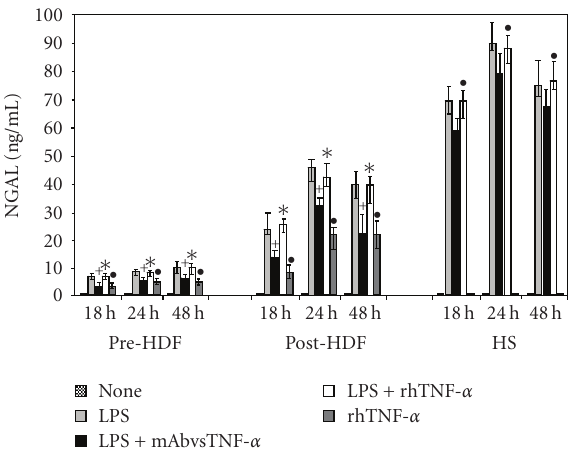
Figure 2: Role of TNF- α on the kinetics of NGAL production by PMG from preHDF and postHDF patients and HS. + Significantly di ff erent ( P < . 05) from that of LPS-stimulated PMG. ∗ Significantly di ff erent ( P < . 05) from that of rhTNF-alpha-treated PMG. ◦ Significantly di ff erent ( P < . 05) from that of unstimulated PMG. • Significantly di ff erent ( P < . 05) from that of rhTNF-alpha-treated PMG.